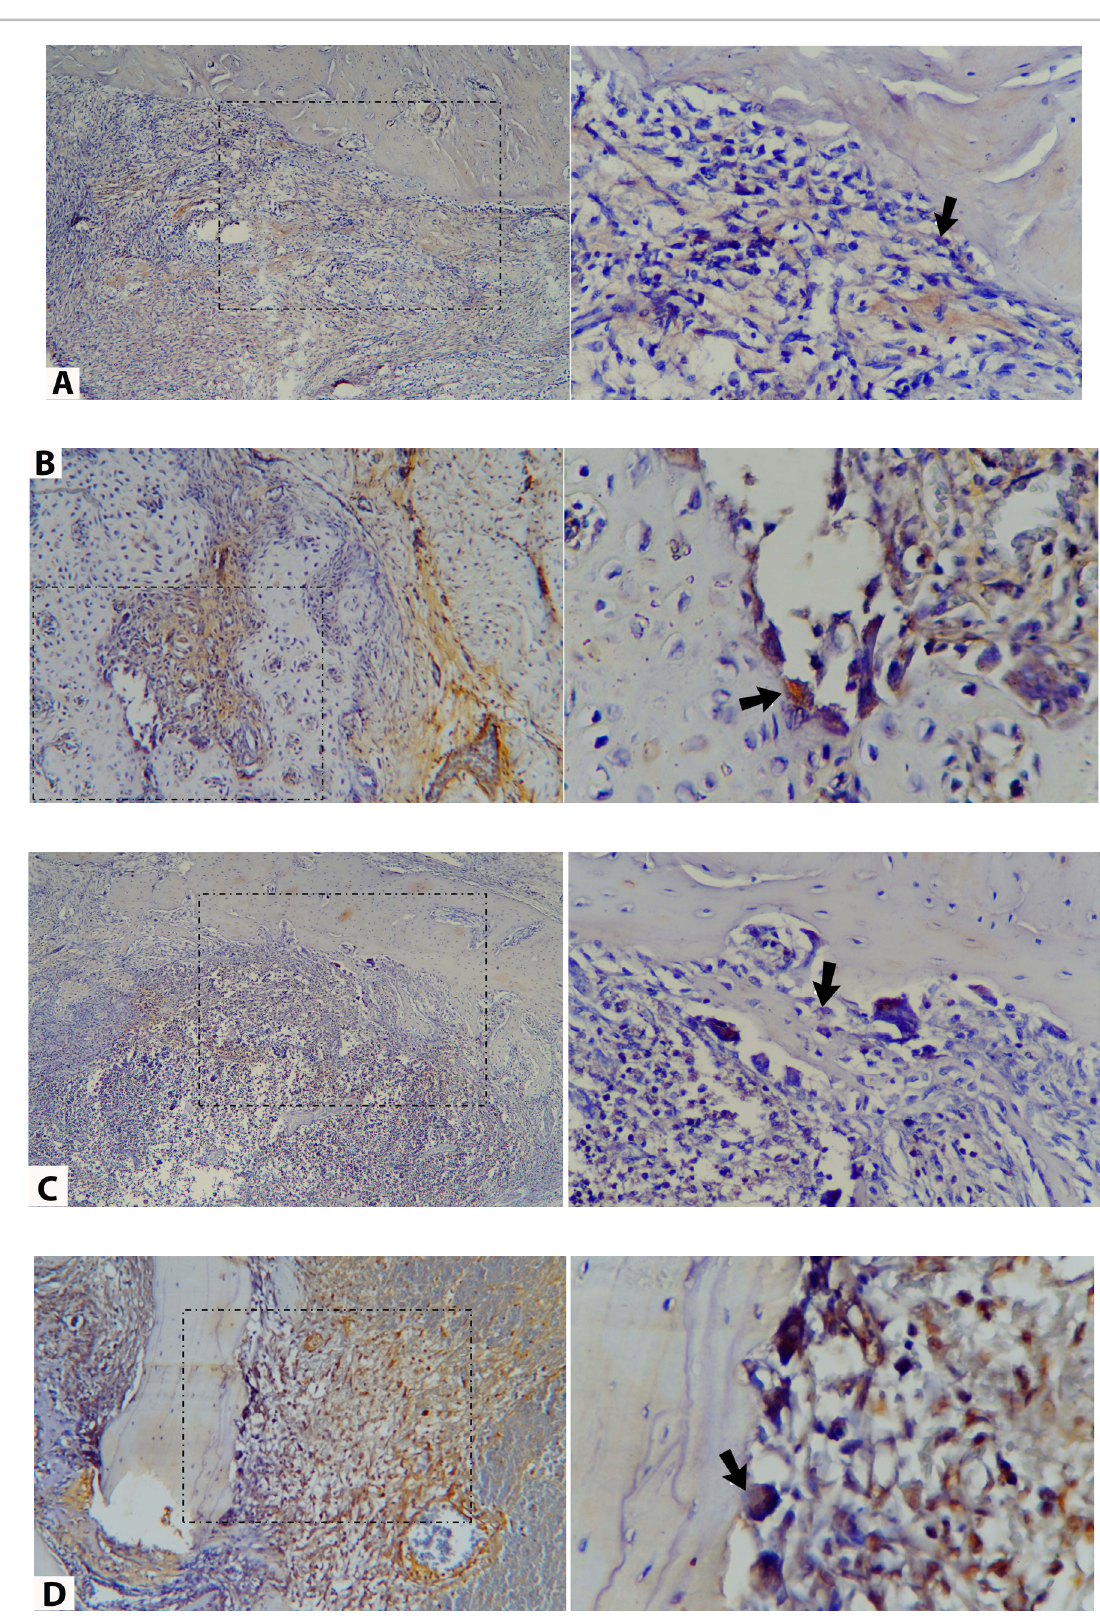
FIGURE 5 - ALP expression on day 30. A. Control / PEG Group, B. Propolis extract + PEG group, C. BBG + PEG group, D. Propolis extract + BBG + PEG group. Each figures consist of 100x and 400x magnification. The arrows showed cell with positive expression of